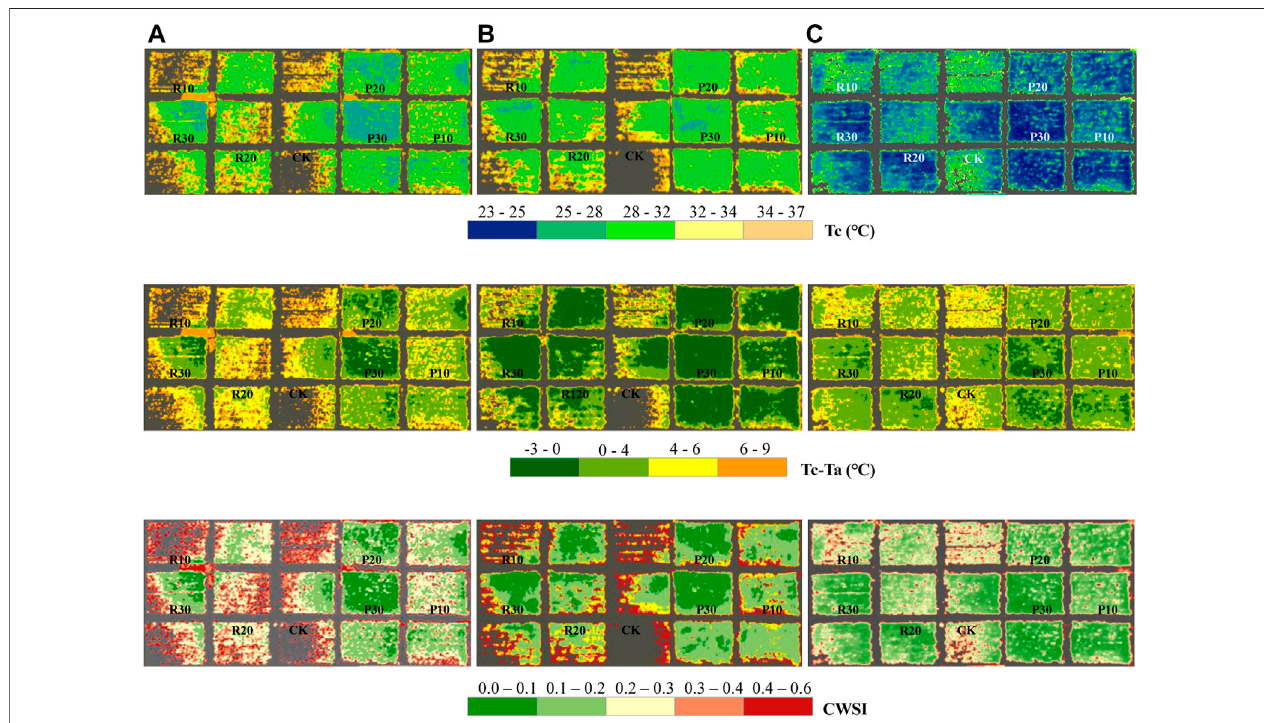
FIGURE 3 | The (1) canopy temperature, (2) difference between the canopy temperature and air temperature, and (3) crop water stress index of alfalfa based on UAVmonitoringbothforthe (A) nutritionalgrowthstage, (B) transitorystage,and (C) reproductivegrowthstage.Theimageswerecollectedat13:00onJuly21,July30, and August 19, 2018. The brown pixels are soil which was not considered in the